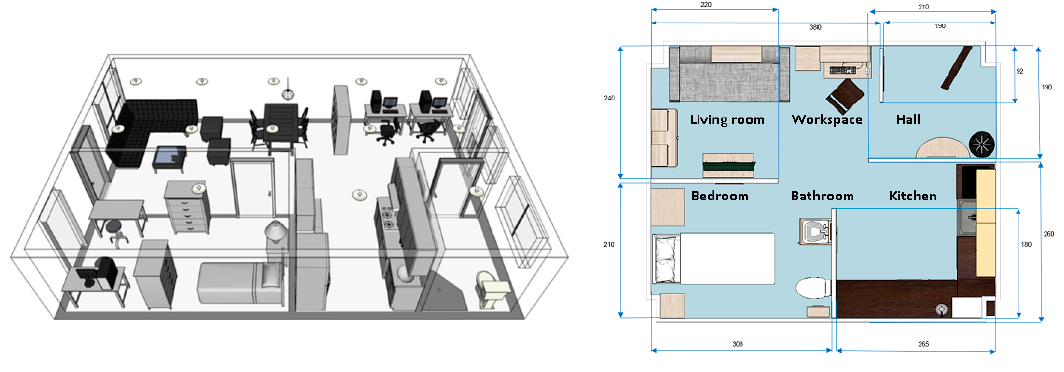
Figure 7. HINT—the Halmstad Intelligent Home ( Left ) and The UJAmI SmartLab ( Right